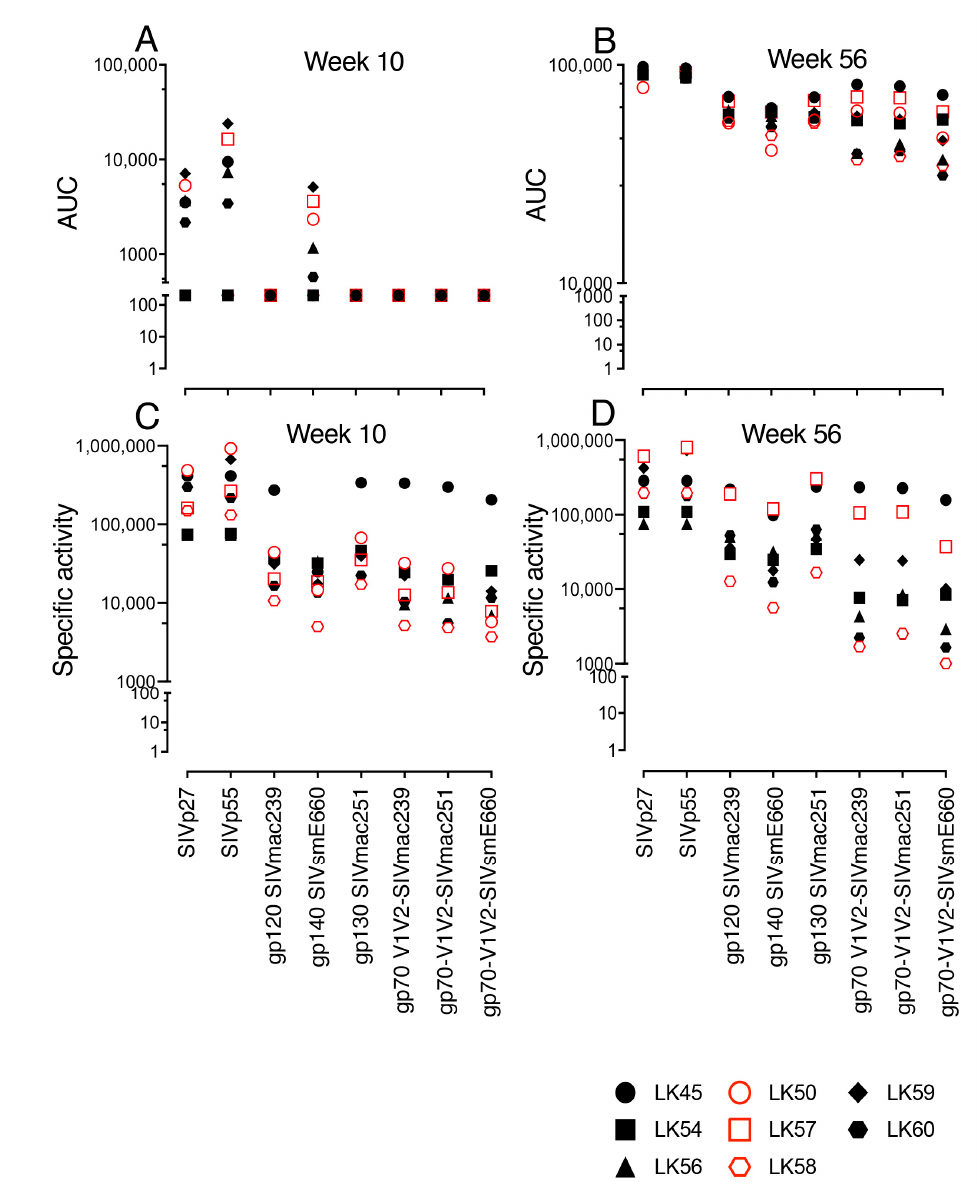
Figure 3. BAMA assay. SIV-specific binding antibody (BAMA) data from all vaccine macaques ( n = 7-8) at 10 weeks and 56 weeks post initial immunization in serum ( A , B ) and vaginal secretions ( C , D ). Individual SIV antigens tested are shown in X axis. Serum IgG binding magnitude data are shown as area under the curve (AUC) in the Y axis ( A , B ) while vaginal secretions data are shown as Specific Activity in the Y axis. ( C , D ). Vaccinated protected (VP) and vaccinated infected (VI) RMs are shown with red and black symbols, respectively.